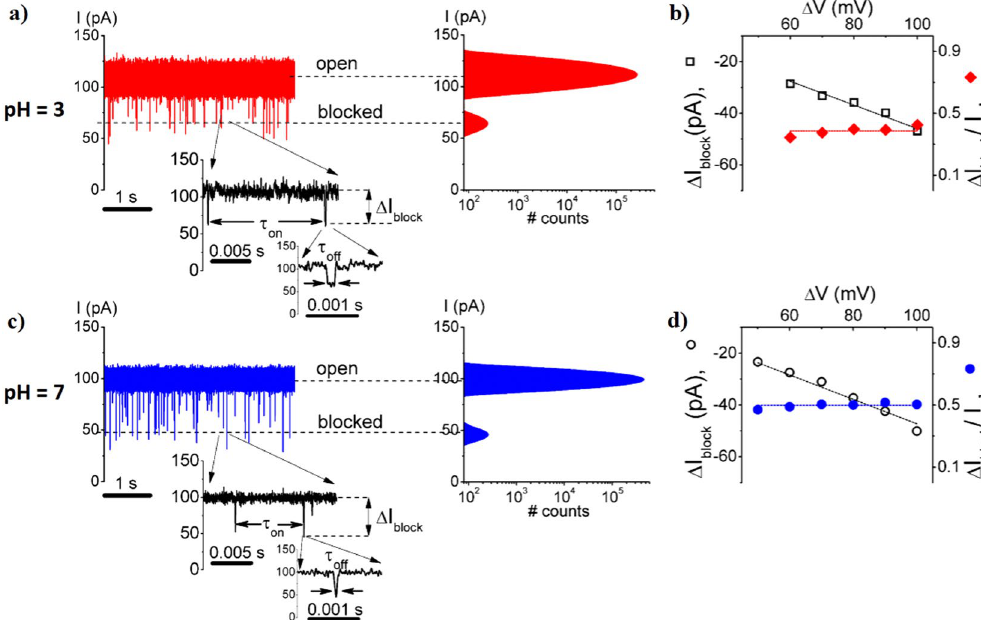
Figure 2. Uni-molecular view of PAMAM-G1 – α -HL interactions at acidic and neutral pH, from electrophysiology traces. Selected ionic current recordings reflecting the PAMAM-G1 – α -HL interactions, and all-events histograms, recorded at Δ V = + 100 mV, in 1 M KCl, at acidic (pH = 3; panel a) and neutral pH (pH = 7; panel c). The dendrimer was trans -added at a bulk concentration of 500 μ M. Indicated are the ionic current levels assigned to the free nanopore (‘open’)(I o ), and the transiently occupied nanopore by a single dendrimer (‘blocked’)(I blocked ). The zoomed-in traces illustrate the main parameters used to describe the electrical signature of the PAMAM-G1 – α -HL interactions ( i . e ., τ on ; inter-event time, τ off ; blockade duration and Δ I block ; current blockage amplitude). In panels b and d we illustrate the Δ I block vs. Δ V dependence (at pH = 3; empty squares ( ◽ ); panel b, and respectively at pH = 7; empty-circles ( ○ ); panel d), and that of the relative current blockade ( Δ I block /I o ) vs. Δ V (at pH = 3; red-filled diamonds ( ⬧ ); panel b, and respectively at pH = 7; blue-filled circles ( ⚫ ); panel